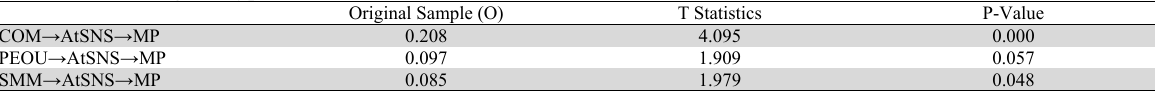
The results of testing the